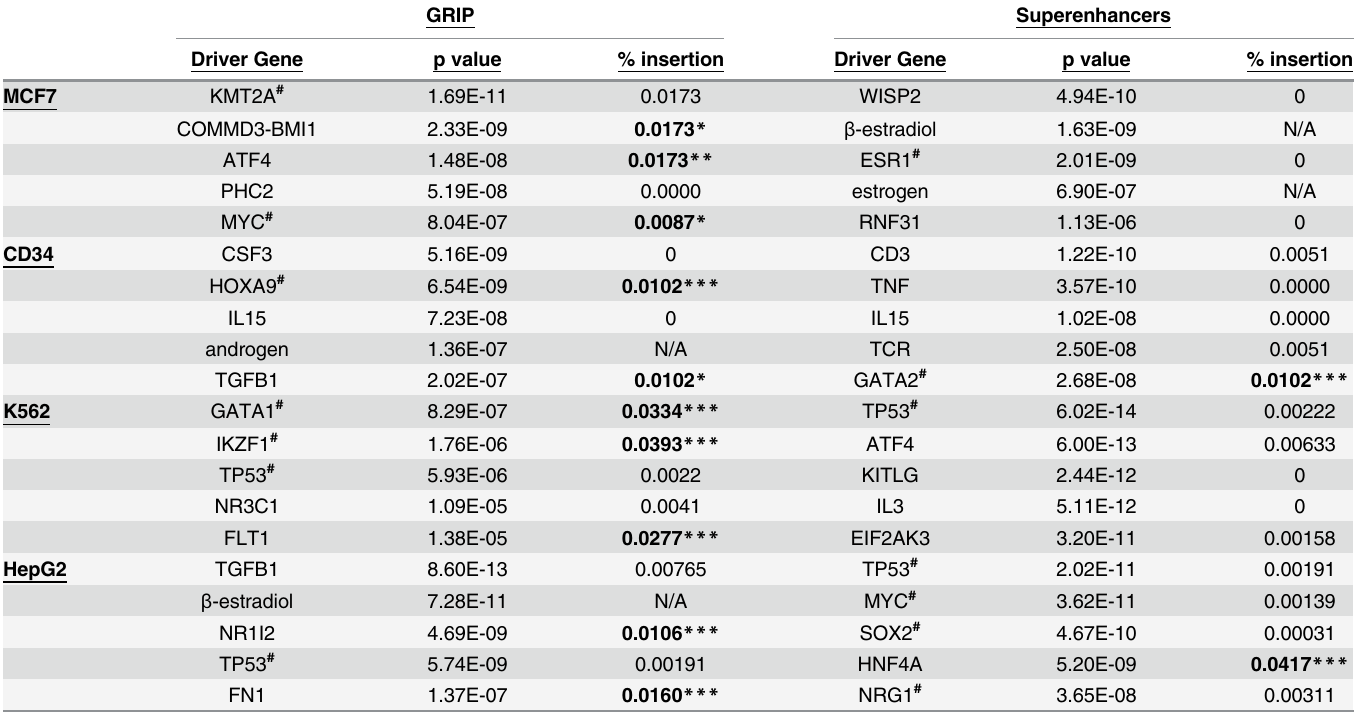
Hash symbol (#) represents a known cancer driver gene, while asterisks represent statistical signi fi cance with * being p < 0.05, ** p < 0.01 and *** p <